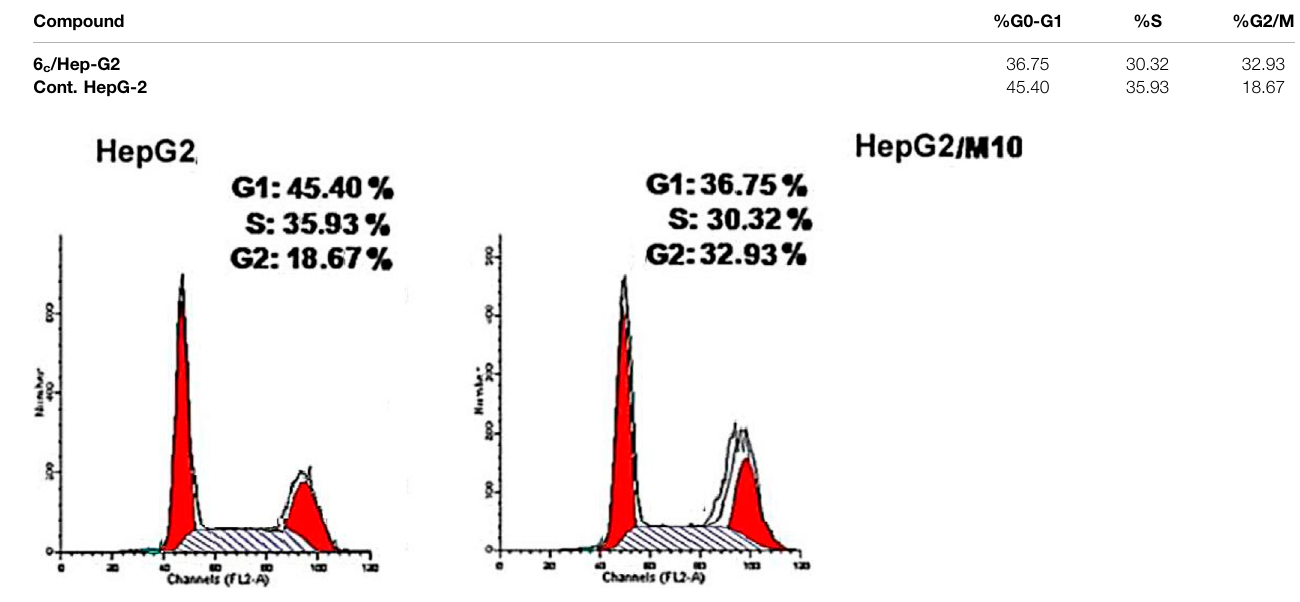
TABLE 3 | Effect of compound 6c on the cell cycle phases of HepG-2 cells.